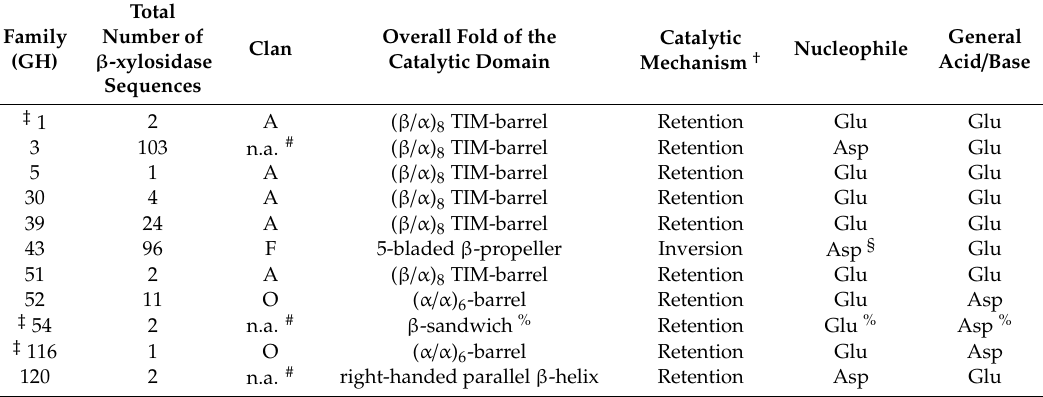
Table 1. Distribution of the current β -xylosidases in the CAZy database, their catalytic domain fold, their type of catalytic mechanism, and their catalytic